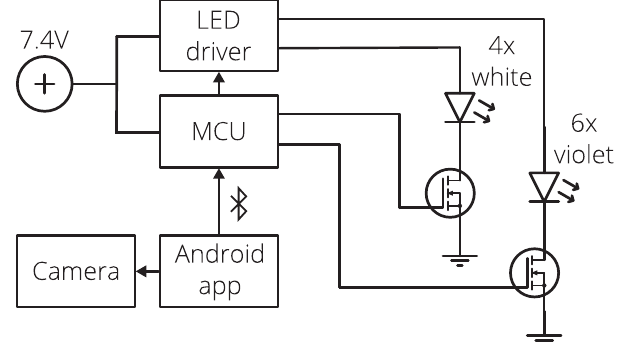
Fig 5. Block diagram of the oral screening system